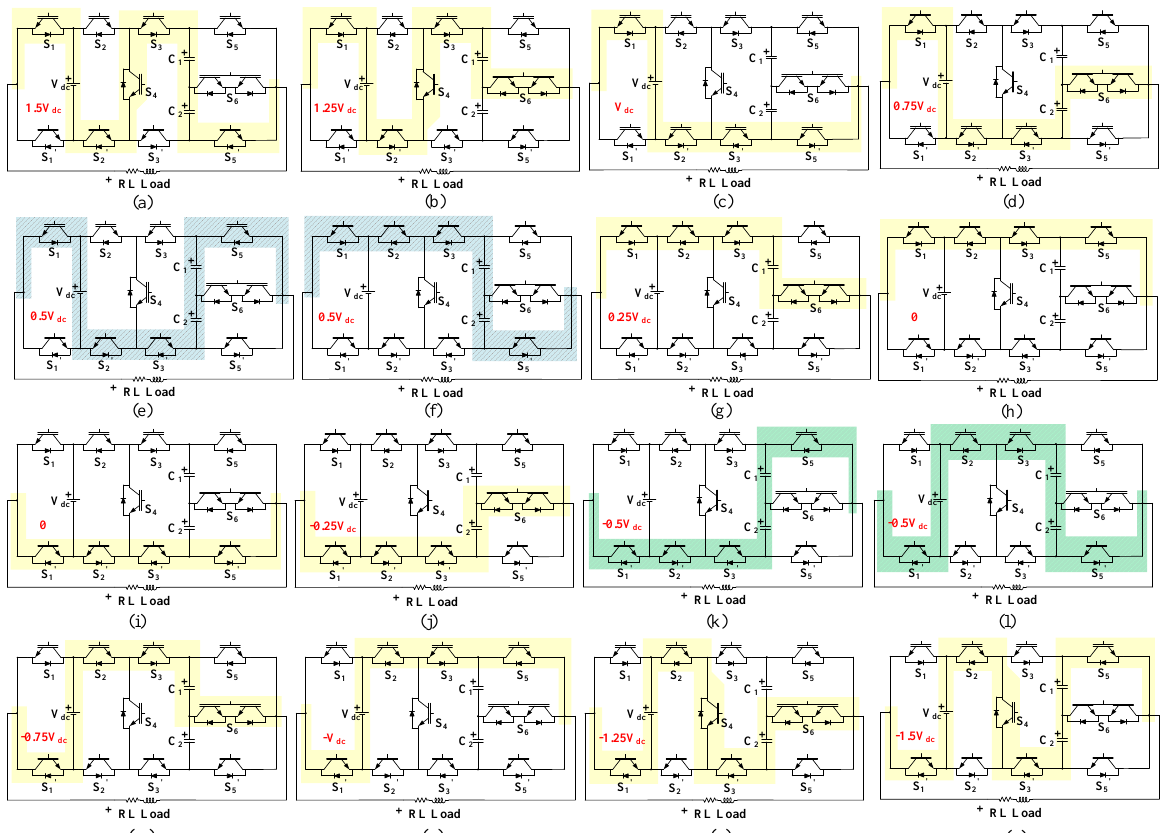
Figure 2. Switching state diagrams of 13-level WE topology .